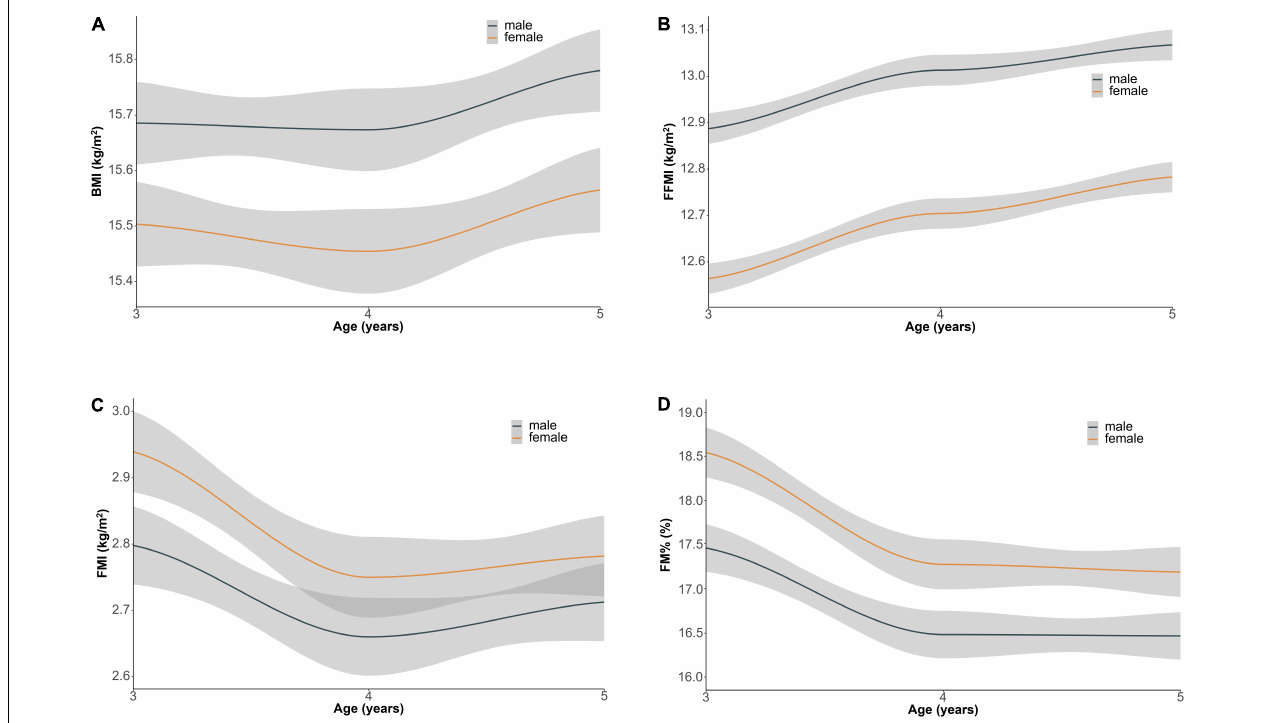
FIGURE 2 | Loess smooth curve of body composition indicators (95% CIs) with age during 3-year follow-up. (A) BMI, (B) FFMI, (C) FMI, and (D) FM%. BMI, body mass index; FFMI, fat free mass index; FMI, fat mass index; FM%, percentage of body fat mass.